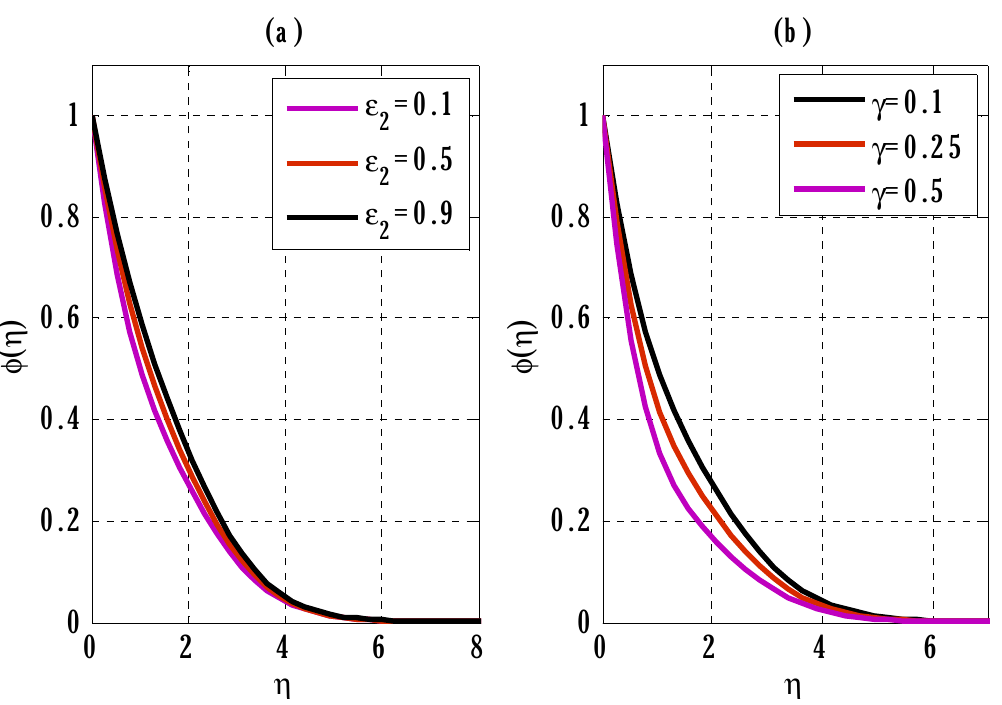
Figure 6. Variation of a small parameter (in variable mass diffusivity) and reaction rate parameter on concentration profile using β = 3, M = 0.1, λ = 0.1, F r = 0.1, N t = 0.1, S c = 1.5, N b = 0.1, E c = 0.4, E 1 = 0.01, ε 1 = 0.9, P r = 1.7, R d = 0.1. ( a ) γ = 0.1 ( b ) ε 2 =